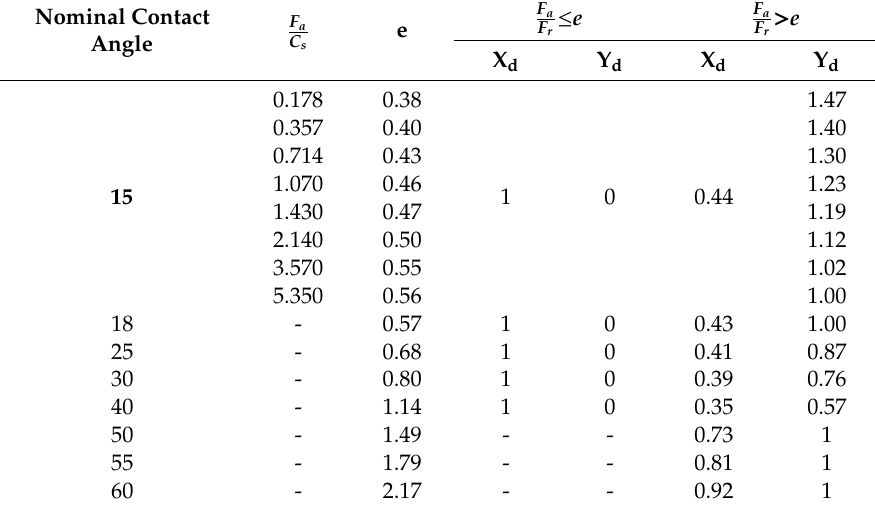
Table A3. Values of dynamic load factor X d and Y d for angular contact bearings [35].